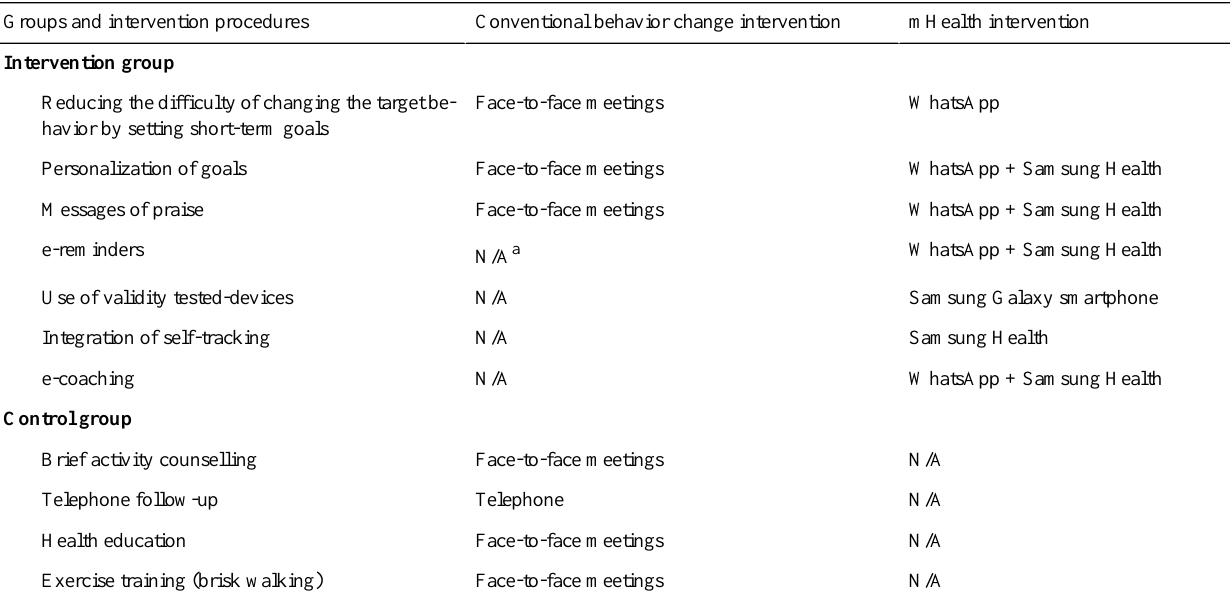
mHealth interventionConventional behavior change interventionGroups and intervention procedures